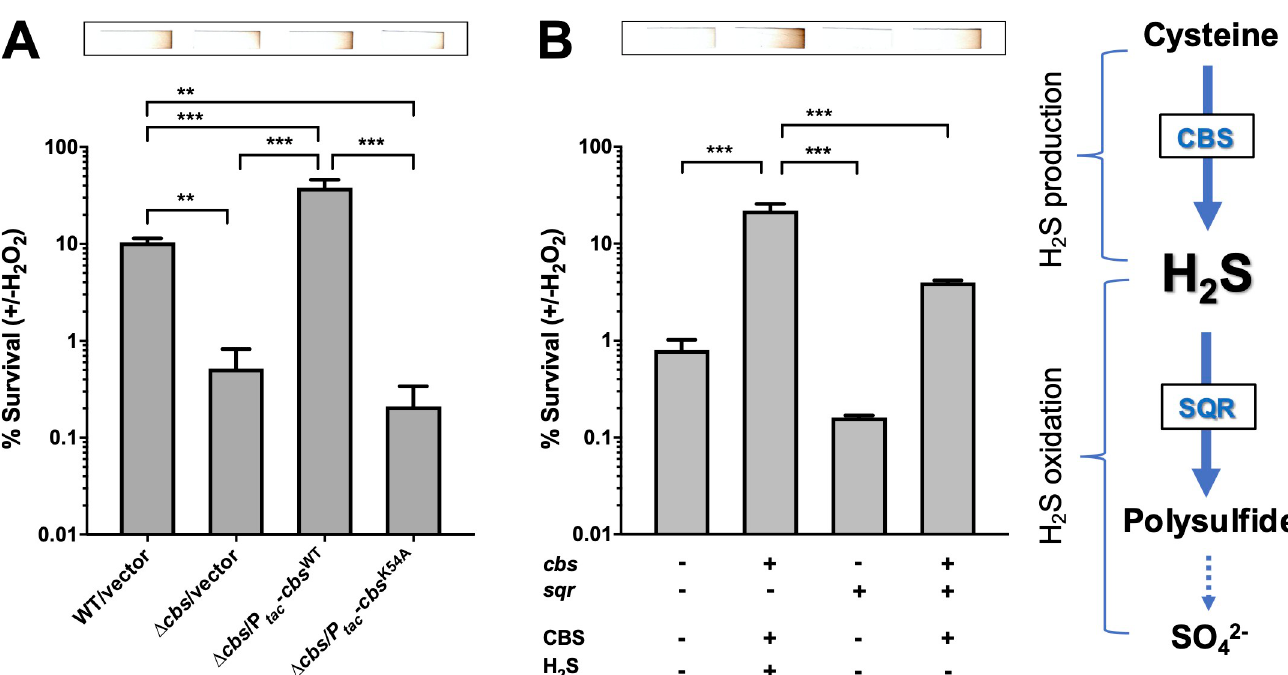
Fig 2. H 2 S is the determinant of H 2 O 2 resistance caused by cbs expression in V . cholerae . (A). CBS-derived H 2 S renders V . cholerae cells less susceptible to H 2 O 2 . Bacteria were exposed to 1 mM of H 2 O 2 for 30 min at their exponential-phase or left untreated in M9 minimal medium (M9 salts plus 2 mM MgSO 4 , 0.1 mM CaCl 2 , and 0.2% casein acid hydrolysate as sole carbon source) containing 200 μ M IPTG. Viability was determined by comparing the CFU in the H 2 O 2 -challenged and the unchallenged samples. Top chart exhibited end-point detection of H 2 S production for the corresponding strains in the bottom chart. Three replicates were sampled for each strain. Significance was determined by one-way ANOVA; p -value: �� , < 0.01, ��� , < 0.001. (B). H 2 S scavenging via the expression of S . aureus sqr gene impairs the protective effect of cbs expression on the survival of V . cholerae . Left panel: survival under H 2 O 2 stress were tested for Δ cbs strains containing vectors only ( cbs - sqr - ), either P ( cbs + sqr - ) or P ( cbs - sqr + ), or both of P and P ( cbs + sqr + ). Bacteria were grown in M9 minimal medium tac -cbs BAD -sqr tac -cbs BAD -sqr containing 200 μ M of IPTG and 0.02% arabinose and exposed to 1 mM of H 2 O 2 for 30 min at their mid-log phase. Viability was determined by comparing the CFU in the H 2 O 2 -challenged and the unchallenged samples. Values expressed are means ± S.D. from three experiments. Significance was determined by one-way ANOVA; p -value: ��� , < 0.001. Top chart exhibits end-point detection of H 2 S production for the corresponding strains in the bottom chart in M9 minimal medium. Right panel: design of H 2 S production and elimination system in V . cholerae cells. In the system, S . aureus sqr gene was introduced to remove the CBS-derived H 2 S by H 2 S oxidation in order to establish a system with only CBS protein